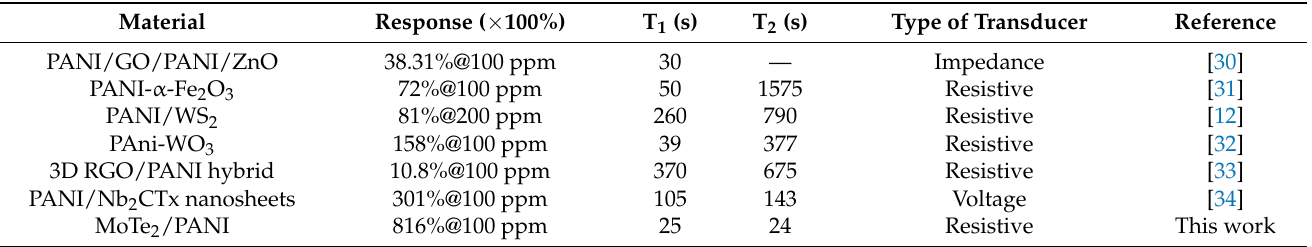
Table 3. Comparison of MoTe 2 /PANI composites based NH3 gas sensor and those reported in the literature.